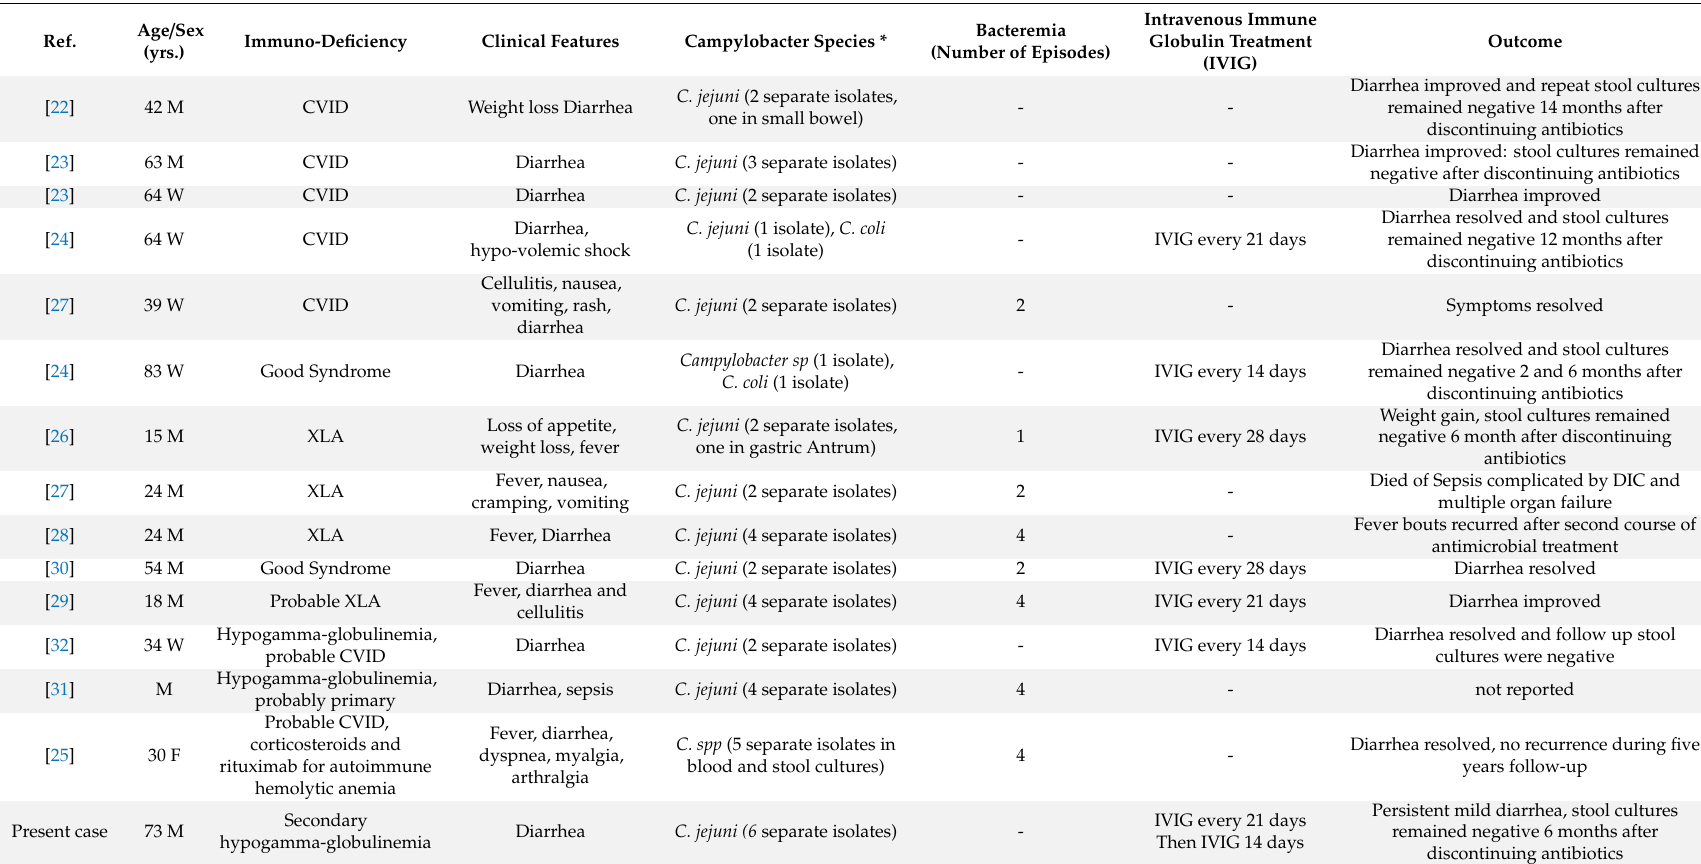
Table 1. Characteristics of published patients with hypogammaglobulinemia and recurrent Campylobacter gastroenteritis.